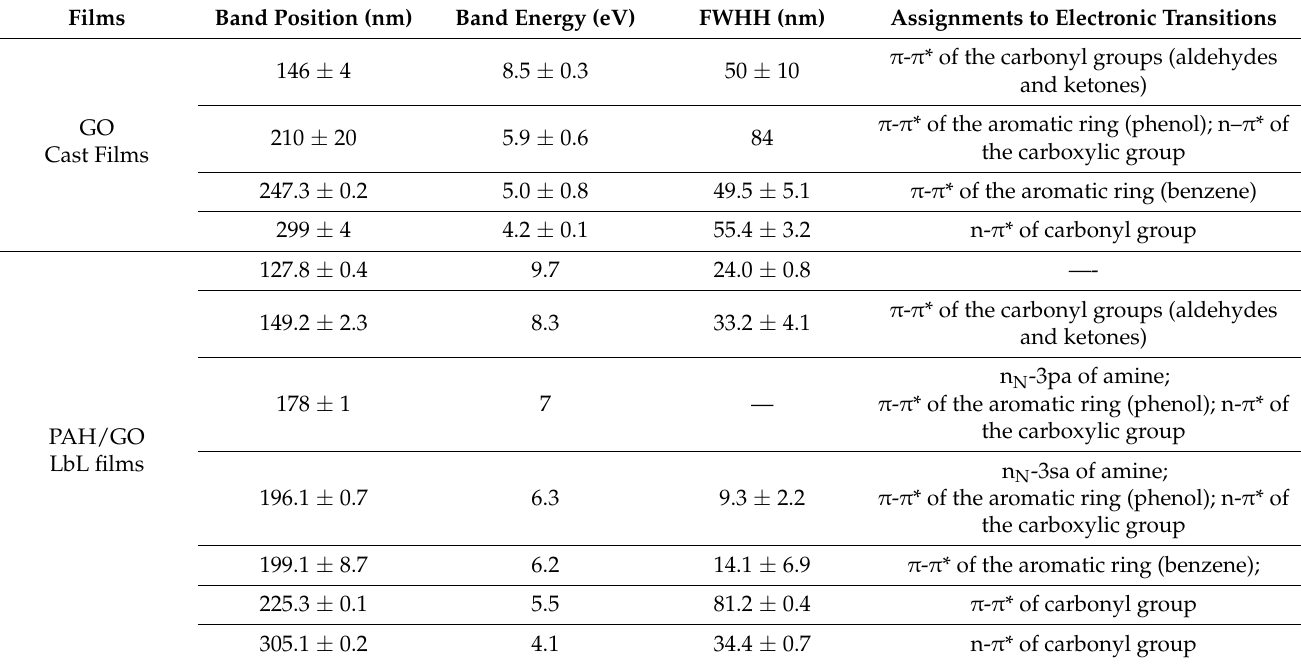
Table 1. Position of the absorption bands, full widths at half height (FWHH) and their respective assignments of the electronic transitions observed in the VUV spectra of GO deposited as cast and PAH/GO LbL films. Films Band Position (nm) Band Energy (eV) FWHH (nm) Assignments to Electronic